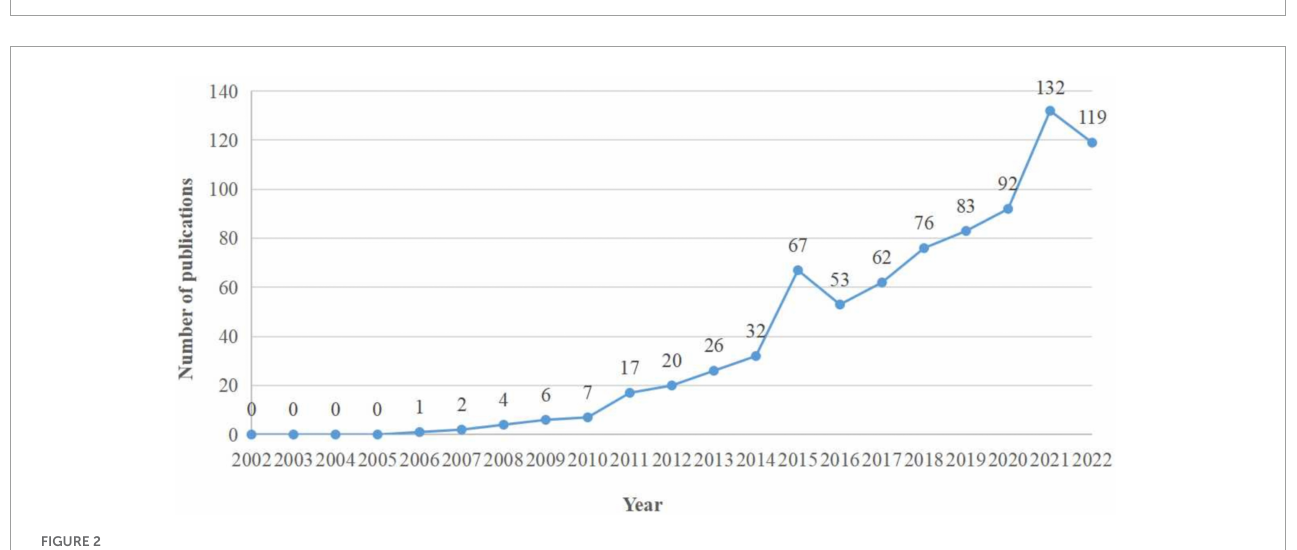
FIGURE2 Trends in the number of publications on NSSI from 2002 to